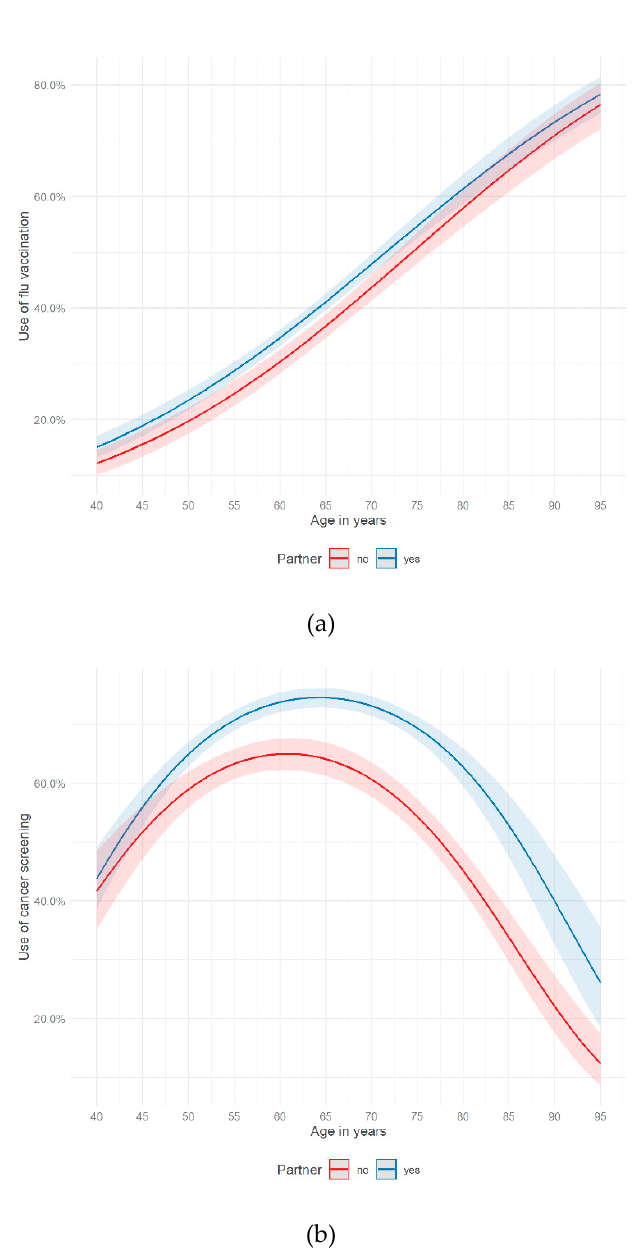
Figure 2. Use of ( a ) flu vaccination (Model 1.2.) and ( b ) cancer screening (Model 2.2.) on age and having a partner (German Ageing Survey, 2014).